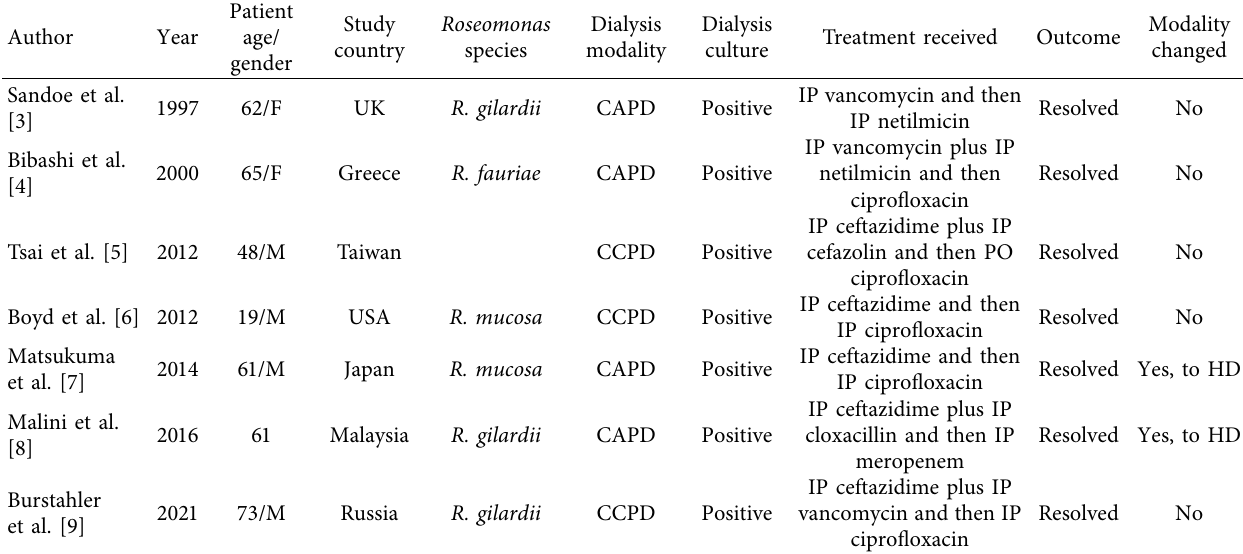
Table 2: Summary of all cases reported to have Roseomonas spp. peritonitis with